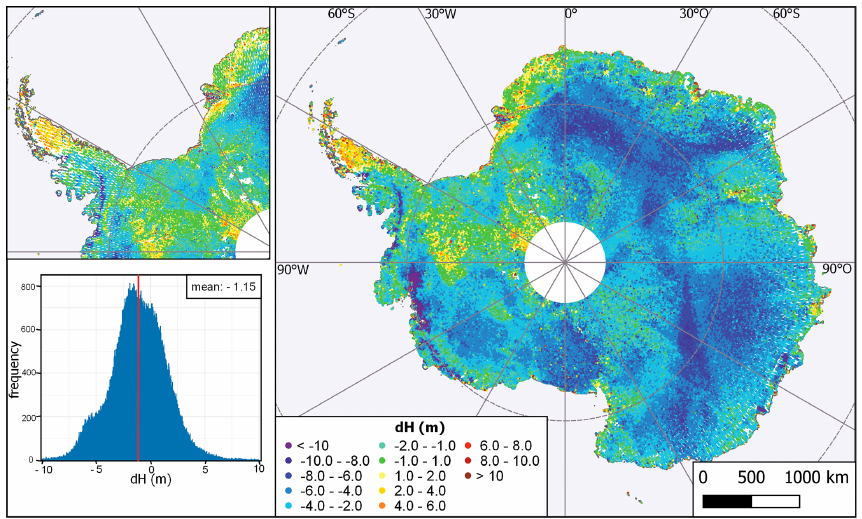
Figure 10. Height differences of TanDEM-X DEM minus ICESat GLA14 elevations over all of Antarctica. Panel on the left: a detailed view on the quadrant of the Antarctic Peninsula with its corresponding histogram of height differences.